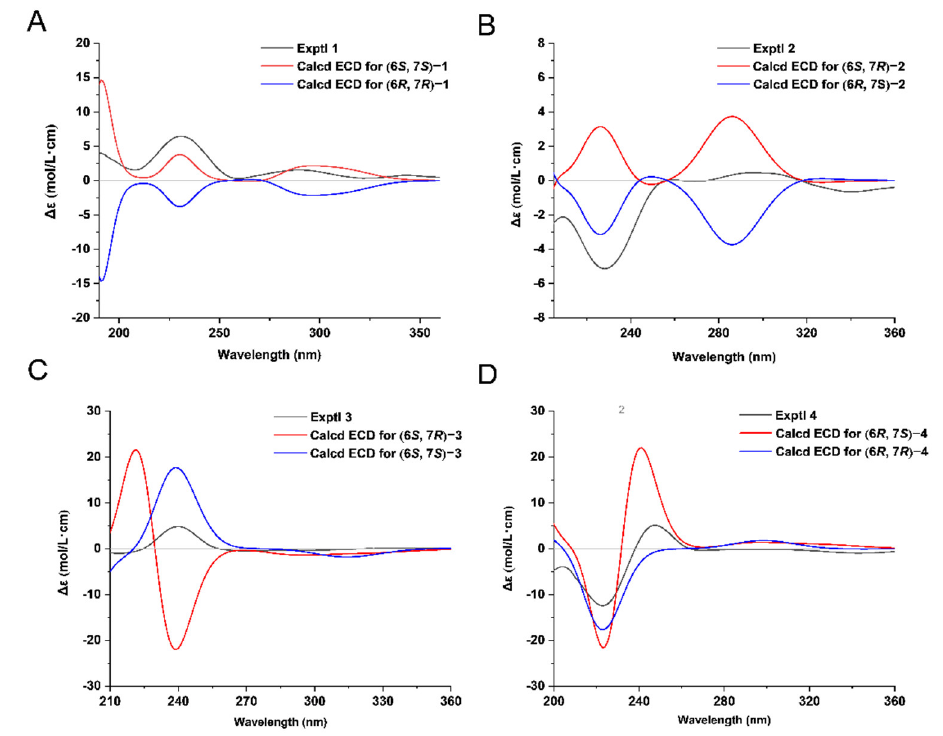
Figure 5. Experimental and calculated ECD spectra of ( A ) compound 1 , ( B ) compound 2 , ( C ) compound 3 , and ( D ) compound 4 .